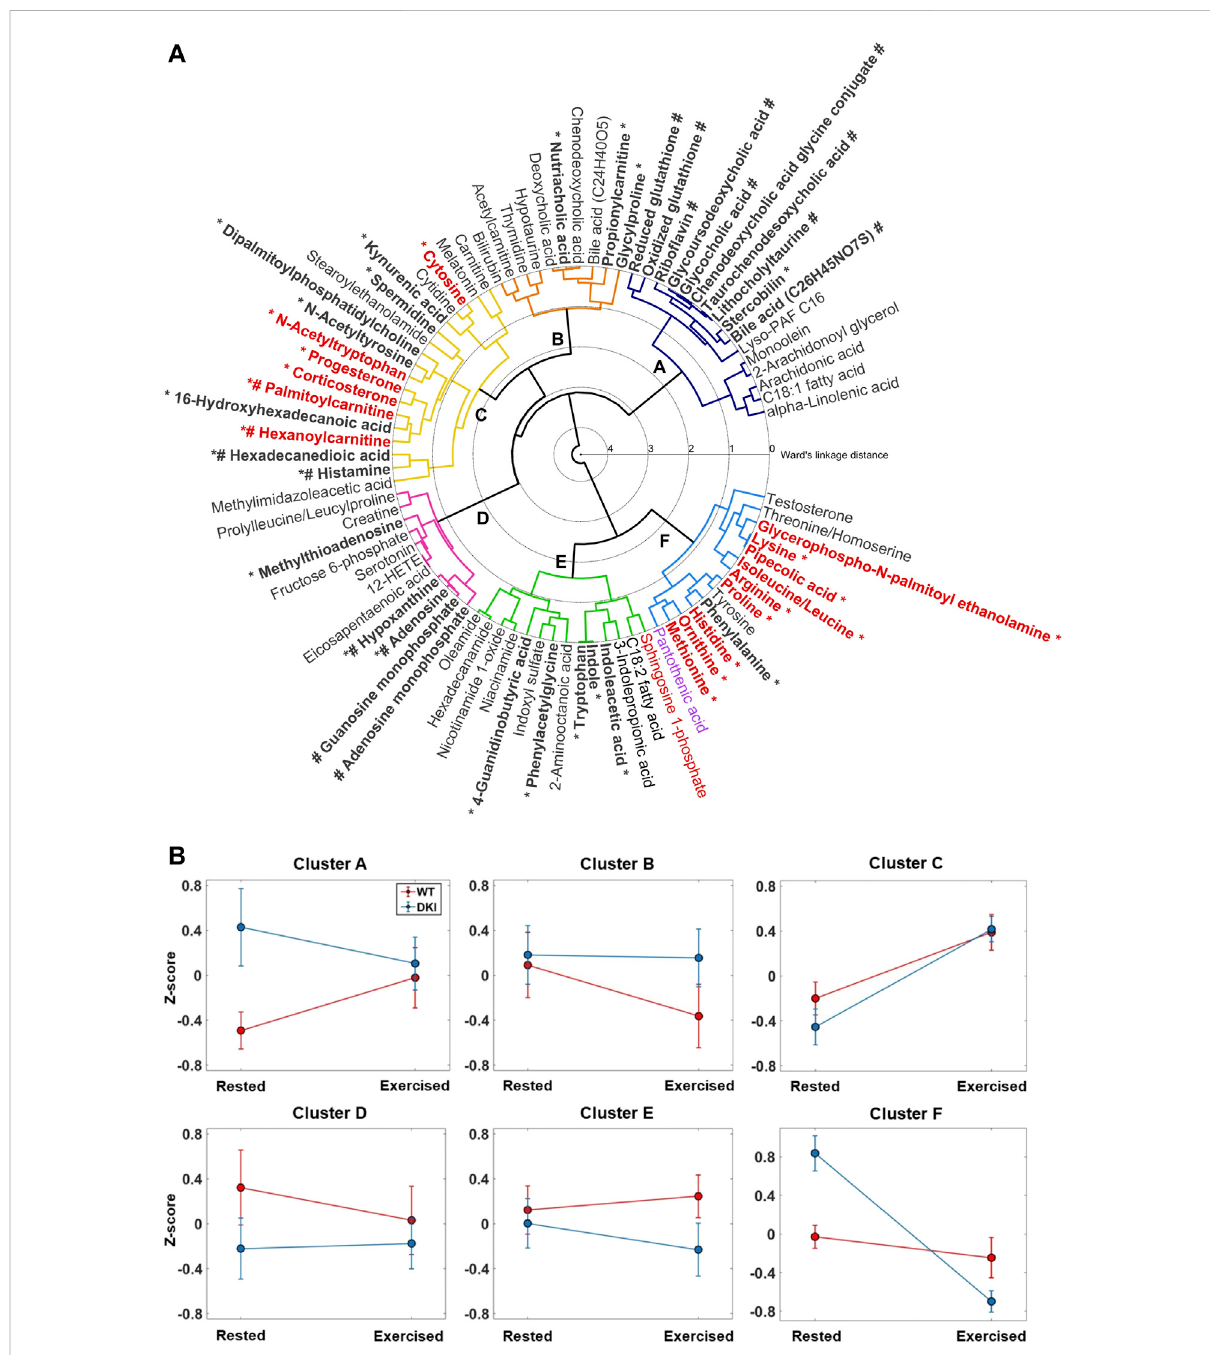
FIGURE 2 Hierarchical Cluster Analysis (HCA) dendrogram of identi fi ed/annotated metabolites. (A) Agglomerative clustering of individual metabolites based on pairwise correlation is shown. The lowest linkages within the HCA dendrogram indicate metabolites that display similar relative responses between the experimental groups. Six clusters were observed. Metabolite labels are colored to re fl ect the results of the two-way ANOVA after fi ltering using a false discovery rate (FDR) of 0.1 (red = signi fi cant effect of condition only; magenta = signi fi cant effect of genotype and condition; black = no signi fi cance or FDR > 0.1). *: Metabolites that signi fi cantly ( p < 0.05) contributed to the model along canonical variate 1 (CV1, Figure 3A); #: Metabolites that signi fi cantly ( p < 0.05) contributed to the model along CV2. (B) Z-scores plot of the mean responses for each metabolite cluster. After conversion of individual metabolite log 10 responses to a z-score, the average response of each cluster was calculated and presented here as a group error bar plot. Error bars indicate the standard error for each group mean (Red = WT; Blue = DKI). Following two-way ANOVA, only Clusters C and F showed signi fi cant differences in the averaged group metabolite response. Cluster C showed a signi fi cant effect of exercise for both genotypes ( p = 2 × 10 − 5 ), and Cluster Fshowed asigni fi cant interaction between genotypeand exercise ( p = 4× 10 − 4 )such that the WT metabolite levels remained constant and the DKI metabolite levels signi fi cantly decreased in response to